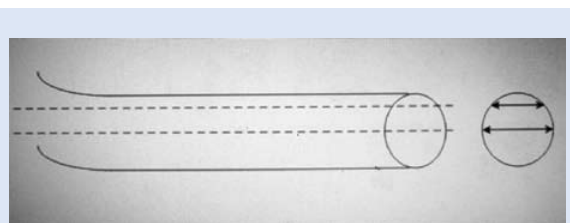
Fig. 3. Illustration of a horizontal, tubular structure. To get an accurate axial diameter of this structure, alignment should be through the centre of the longitudinal axis of the structure. Concentric or asymmetrical compression limits the ability to measure this on routine axial CT.